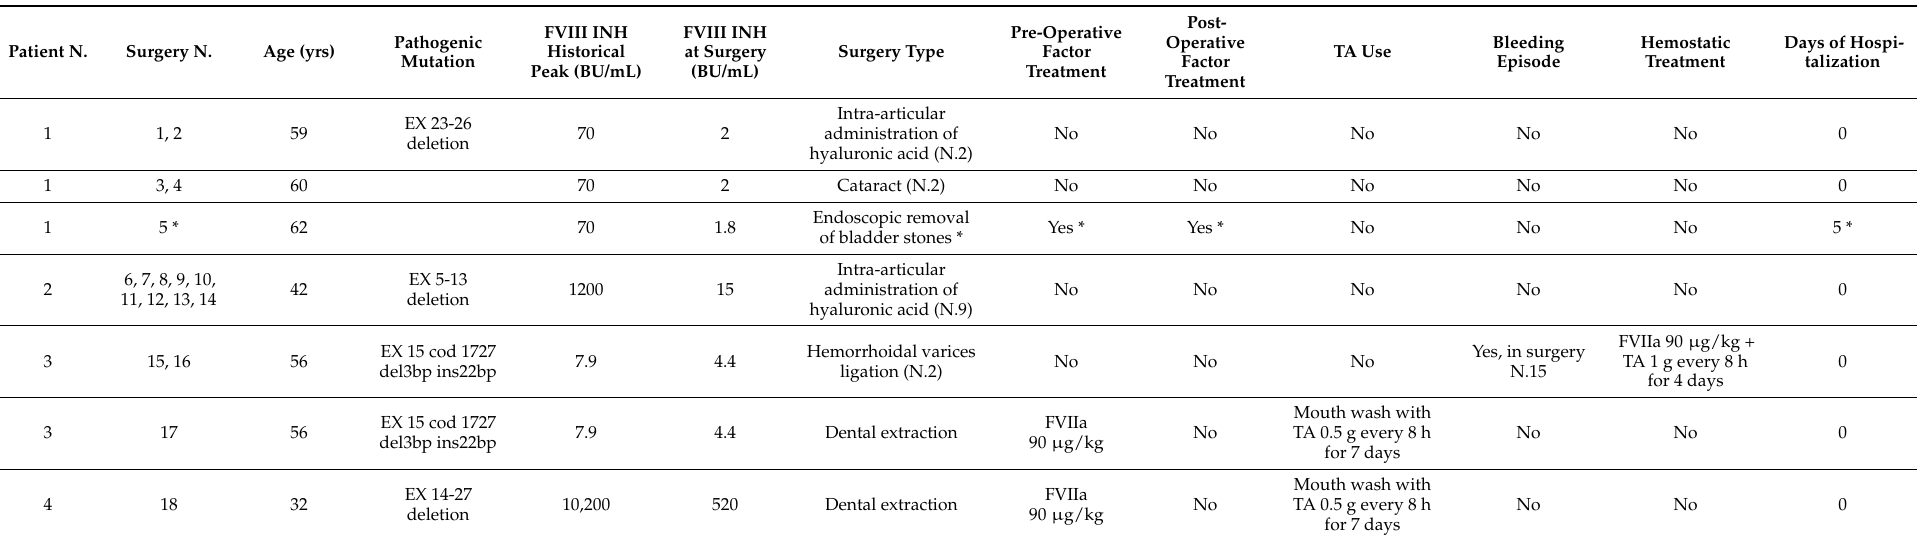
Table 2. Minor surgeries in PWSHA and